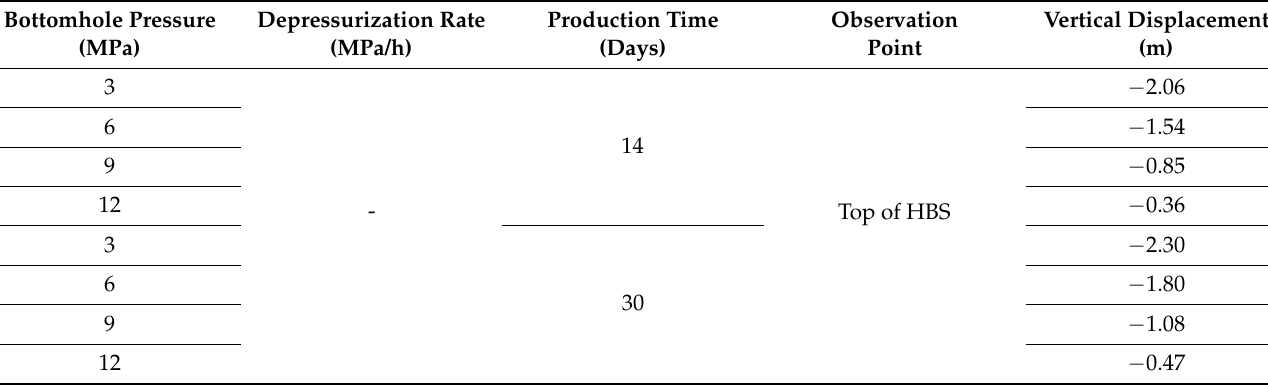
Table 3. Results of vertical displacements in this